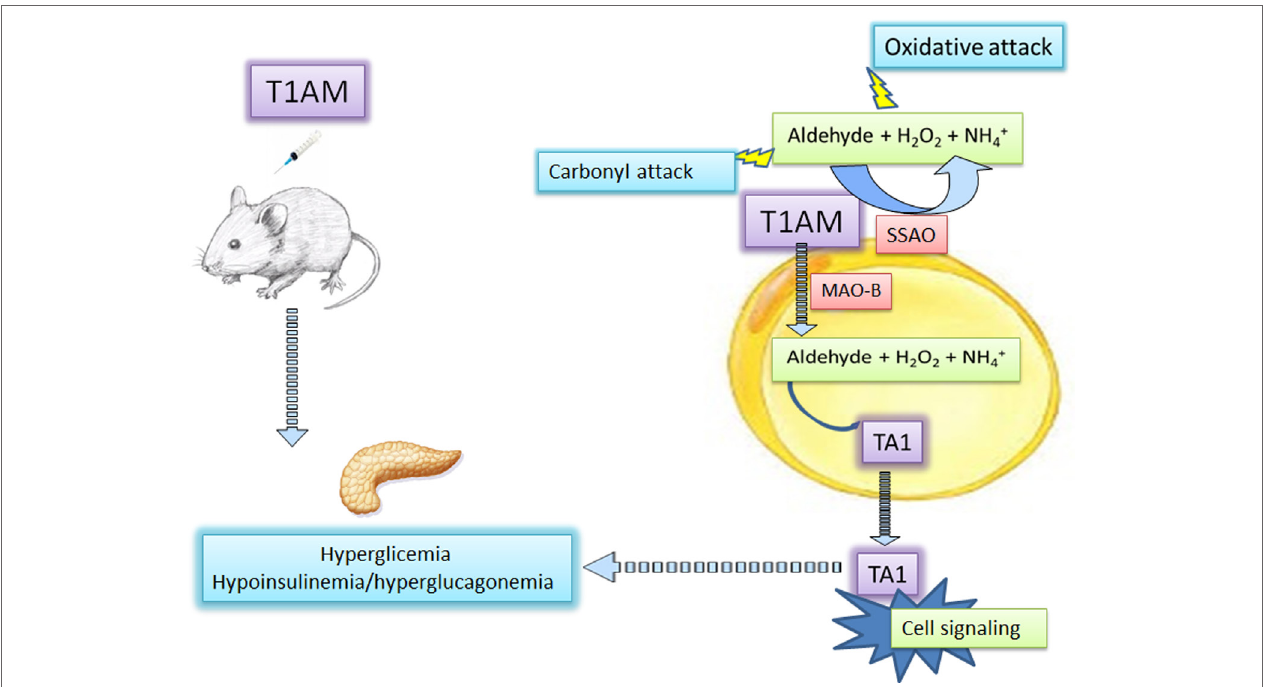
FIGUre 1 | 3-Iodothyronamine and hyperglycemia: the mediation of amine oxidases. 3-Iodothyronamine (T1AM) injected in mice induces hyperglycemia likely interacting at different pancreatic receptors promoting glucagon and reducing insulin release. At insulin-sensitive cells, including the pancreas, T1AM is converted into 3-iodotyroactic acid (TA1), the oxidative metabolite of T1AM by the activities of mitochondrial monoamine oxidase (MAOs), or semicarbazide-sensitive amine oxidases (SSAOs). TA1 can diffuse from cells and induce cell signaling activities and promoting hyperglycemia. The secondary product of amine oxidase activities, i.e., hydrogen peroxide (H 2 O 2 ) and the aldehyde, may promote oxidative attack to cell